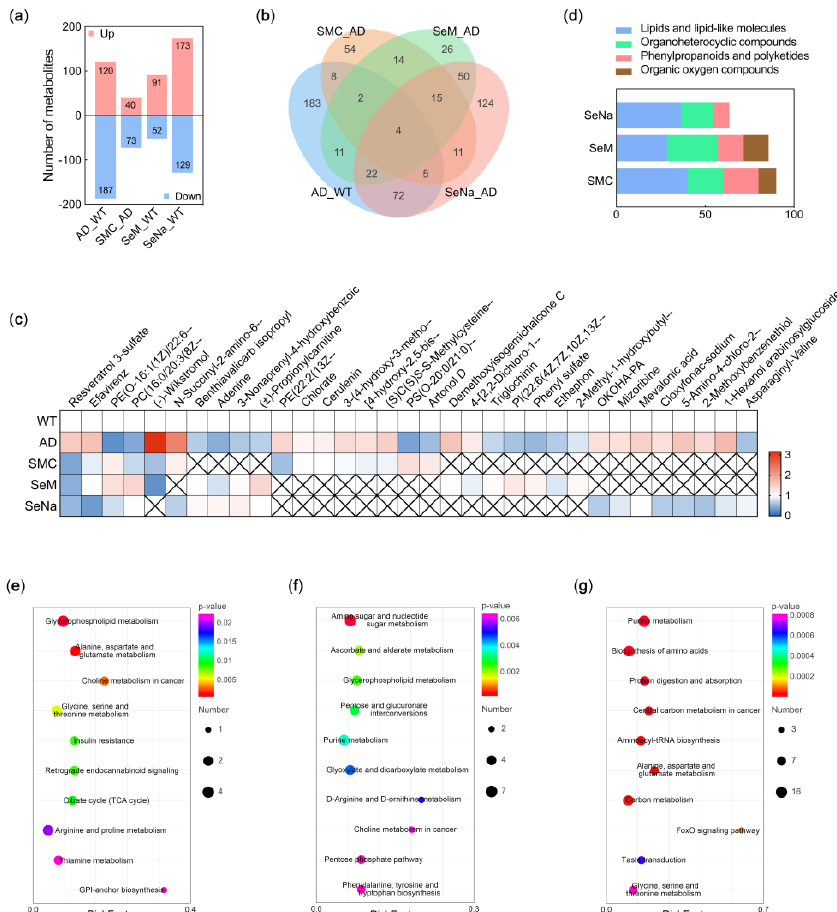
Figure 4. LC-MS untargeted metabolomic analysis revealed altered metabolites and metabolic pathways in the comparisons of AD VS WT, SMC VS AD, SeM VS AD, and SeNa VS AD ( n = 6 mice). ( a ) Number of upregulated and downregulated metabolites in the four comparisons. ( b ) Venn diagram with the number of differential metabolites in the four comparisons. ( c ) Heatmap of reversed metabolites in the four comparisons. ( d ) Superclass of reversed metabolites with administration of the three Se compounds. ( e – g ) KEGG enrichment analysis of differential metabolites in the three comparisons of SMC VS AD, SeM VS AD, and SeNa VS